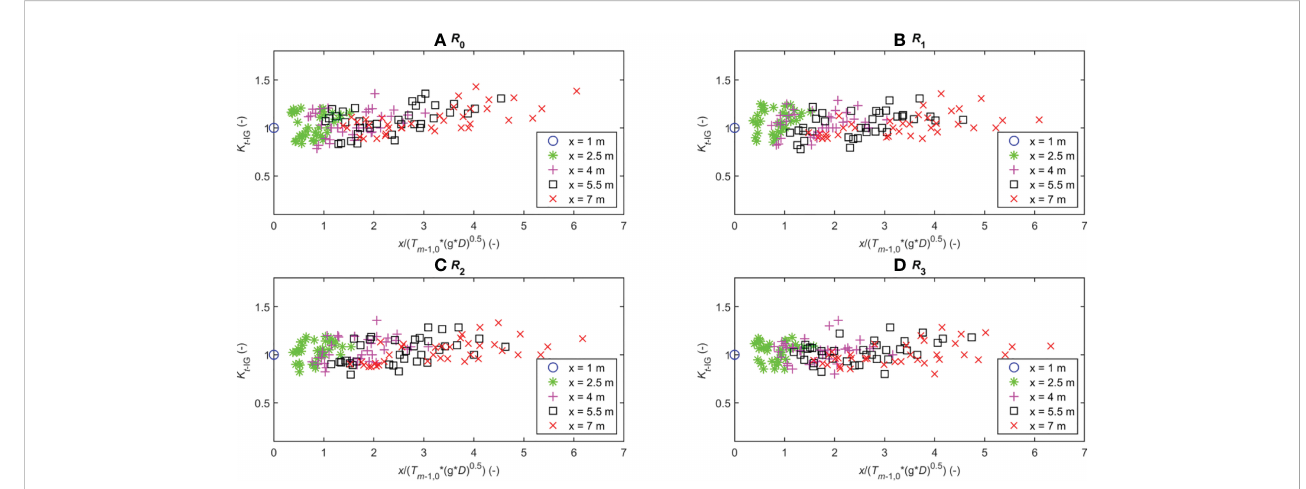
FIGURE 8 Variation in the wave transmission coef fi cient K t-IG along the reef: (A) Smooth reef; (B) Crushed stone reef 1; (C) Crushed stone reef 2; (D) Simulated coral reef.